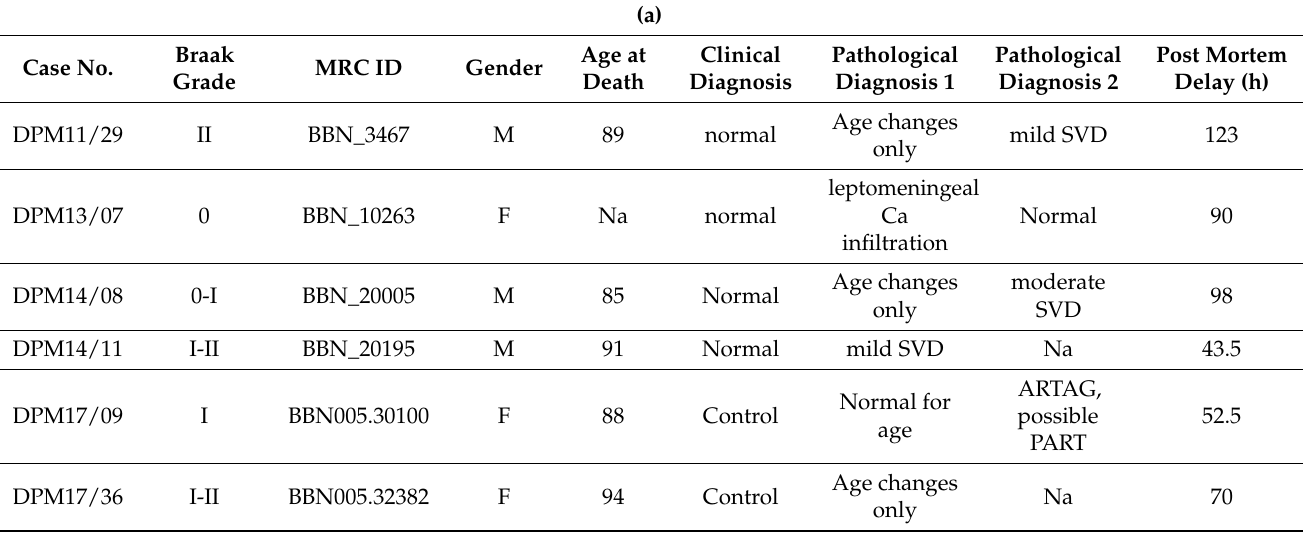
Table 1. ( a ) Normal ageing cases. ( b ) Alzheimer’s disease